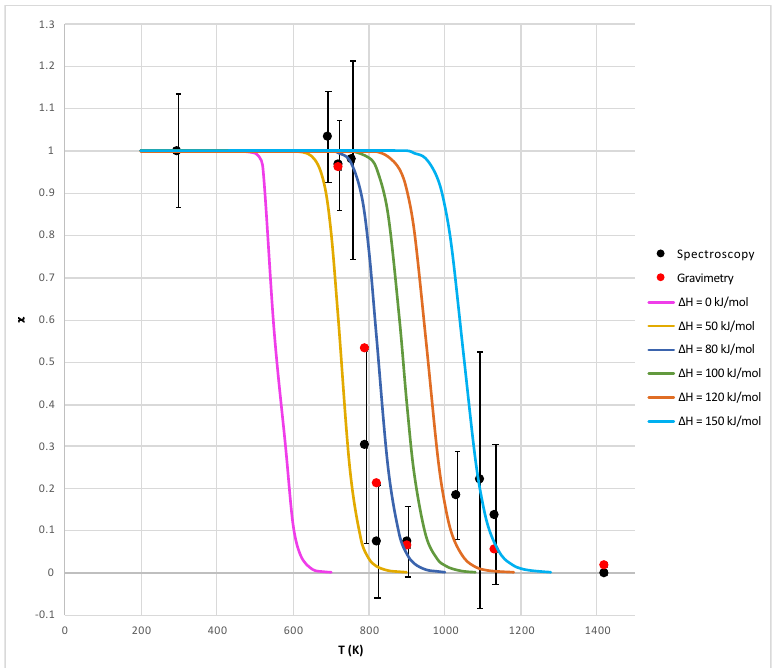
Figure 5. Comparison between the theoretical values (solid lines) of the χ parameter obtained by Equation (12) and the experimental ones (circle dots) obtained for sample S1 both by gravimetric (Equation (13)) and spectroscopic (Equation (15)) techniques (see Table 1). The error bars relative to the temperature T (in abscissae) and to χ gravimetry (in ordinates) are within the size of the dots. Instead, the error bars relative to χ spectroscopy (also in ordinates) are obtained as discussed in the